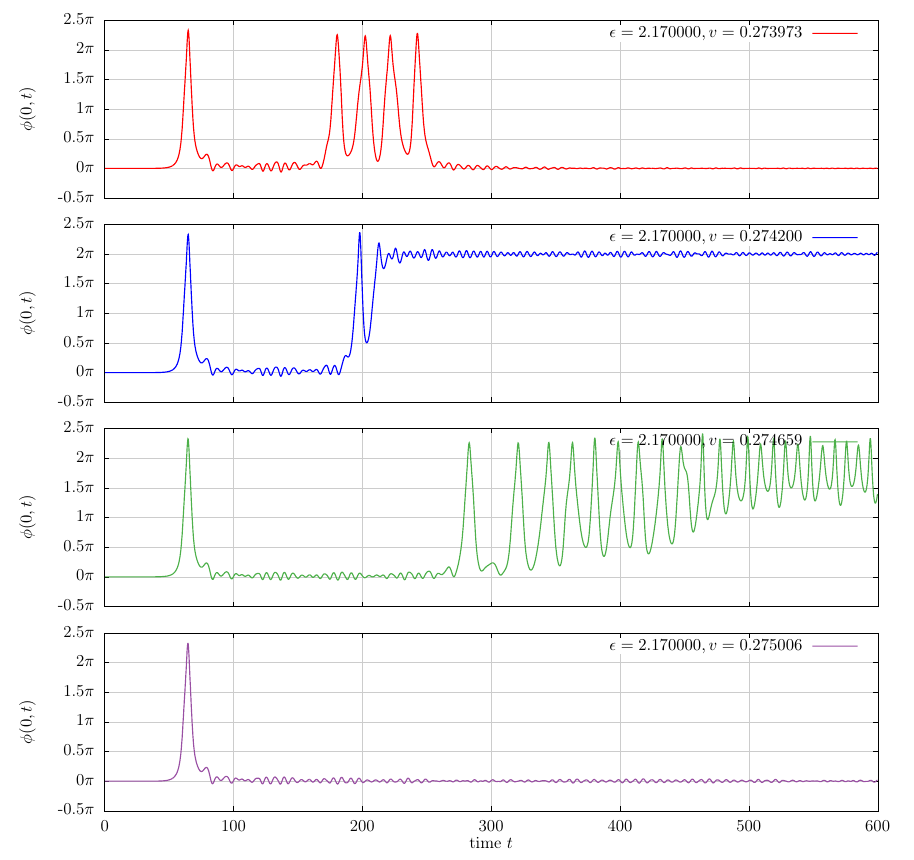
Figure 18 . Evolution of the field at x = 0 for four values of the initial velocity with (cid:15) = 2 . 17 , β = 1 . 19 showing a true window, a pseudowindow, an annihilation to a centrally-located bion, and kink-antikink escape. The presence of higher modes can be seen in the more irregular oscillations of the field after the first collision compared to figure 13. Longer-time views of the full spacetime evolution of the field for these collisions are shown in figure 19